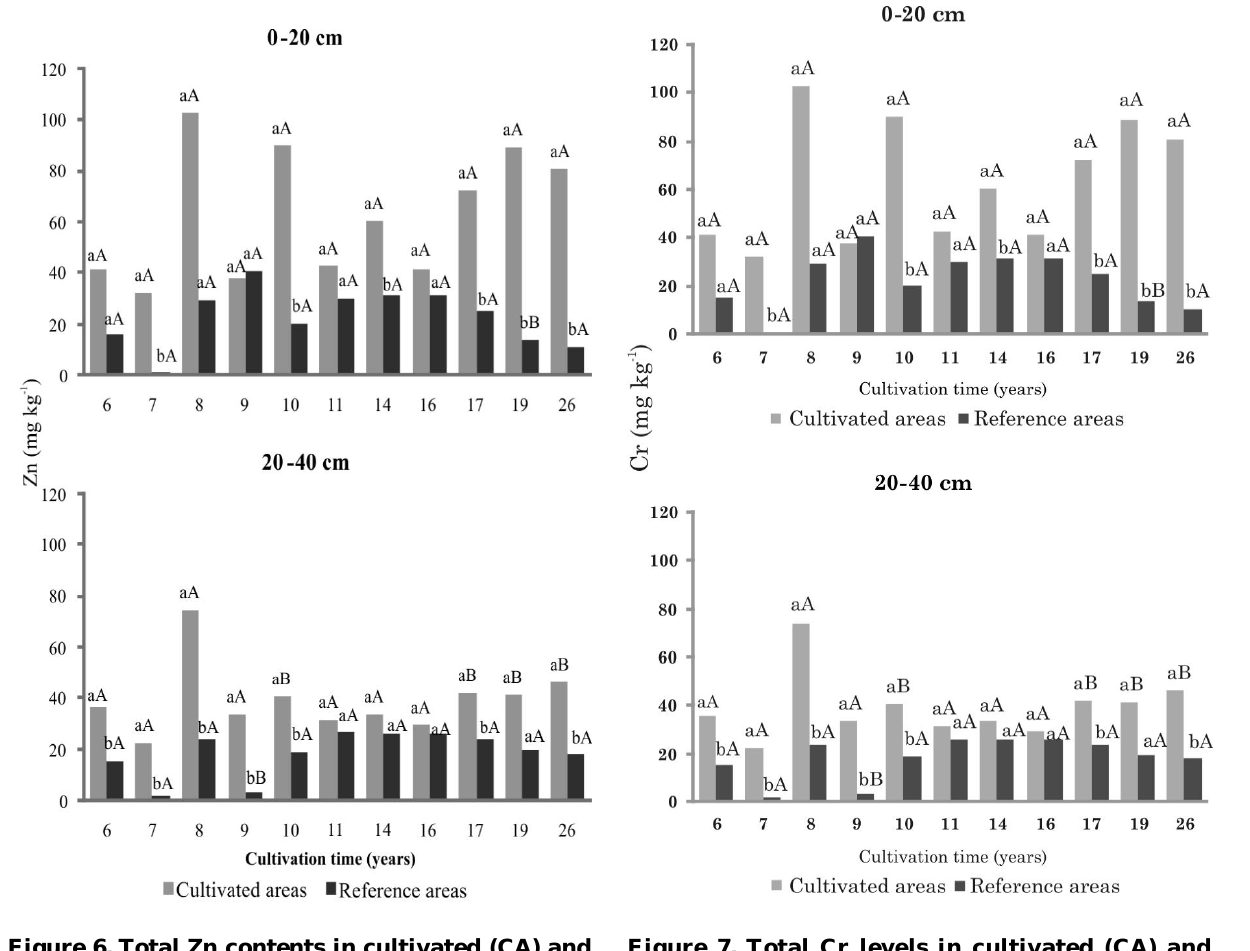
Figure 7. Total Cr levels in cultivated (CA) and reference areas (RA) in two layers (0-20 and 20- 40 cm) after different cultivation periods. Means followed by lowercase letters between environments (CA and RA) and capital letters between layers (0-20 and 20-40) did not differ statistically by Tukey’s test (p (cid:172)(cid:31)(cid:172)